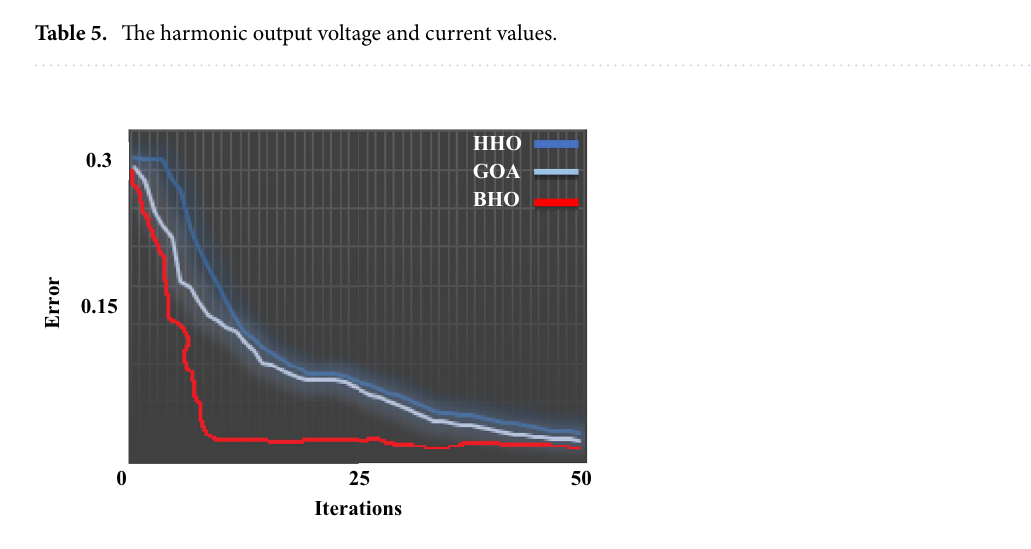
Figure 21. The iteration diagram of